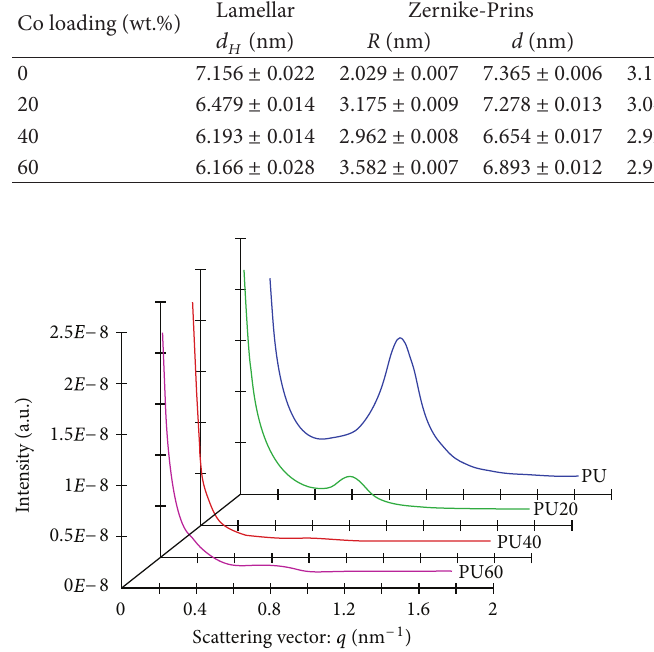
F 2: SAXS pro�les of PU composites loaded with 0–60wt. Co showing the normalized scattering intensity as a function of the scattering